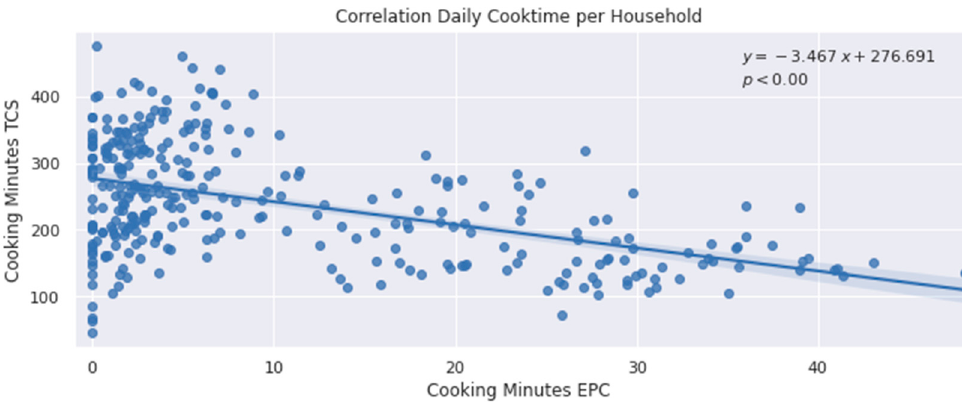
Figure 14. Relationship between daily use of EPC and TCS (mean minutes/day) (average across 28 households).